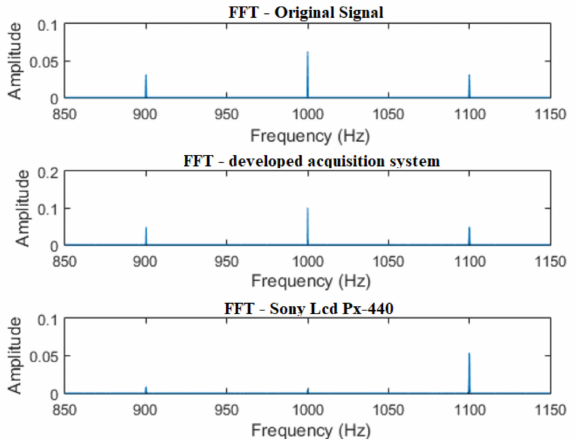
Figure 19. FFT of an AM signal—carrier: 1 kHz/modulator: 100